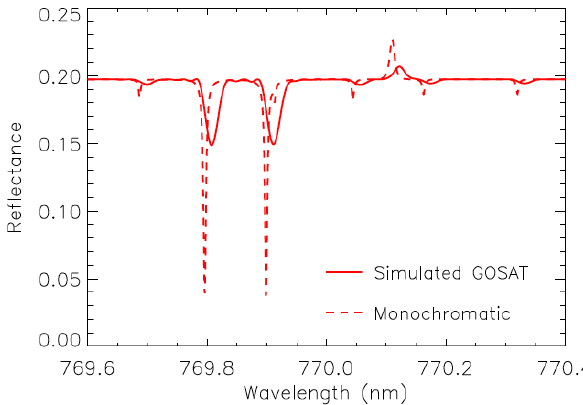
Fig. 2. Simulated monochromatic and GOSAT reflectance spectra assuming a fluorescence of 3mWm − 2 sr − 1 nm − 1 , θ = 45 ◦ , surface albedo=0.2.